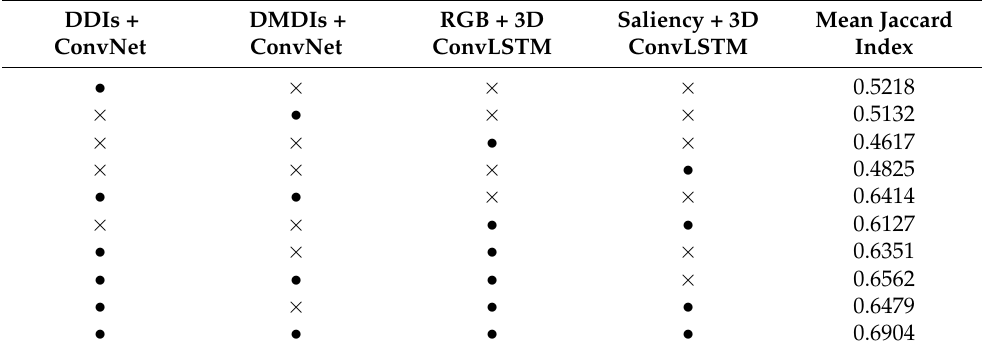
Table 3. The evaluation of different features on the validation set of ChaLearn LAP ConGD Dataset.